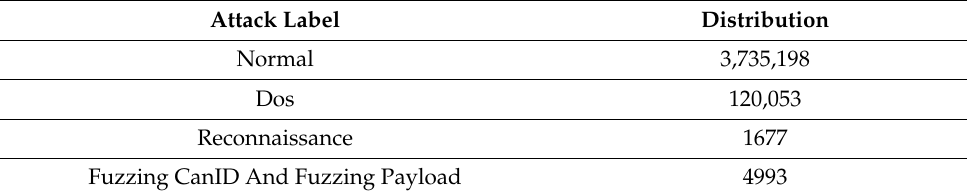
Table 6. Value repartition for attack